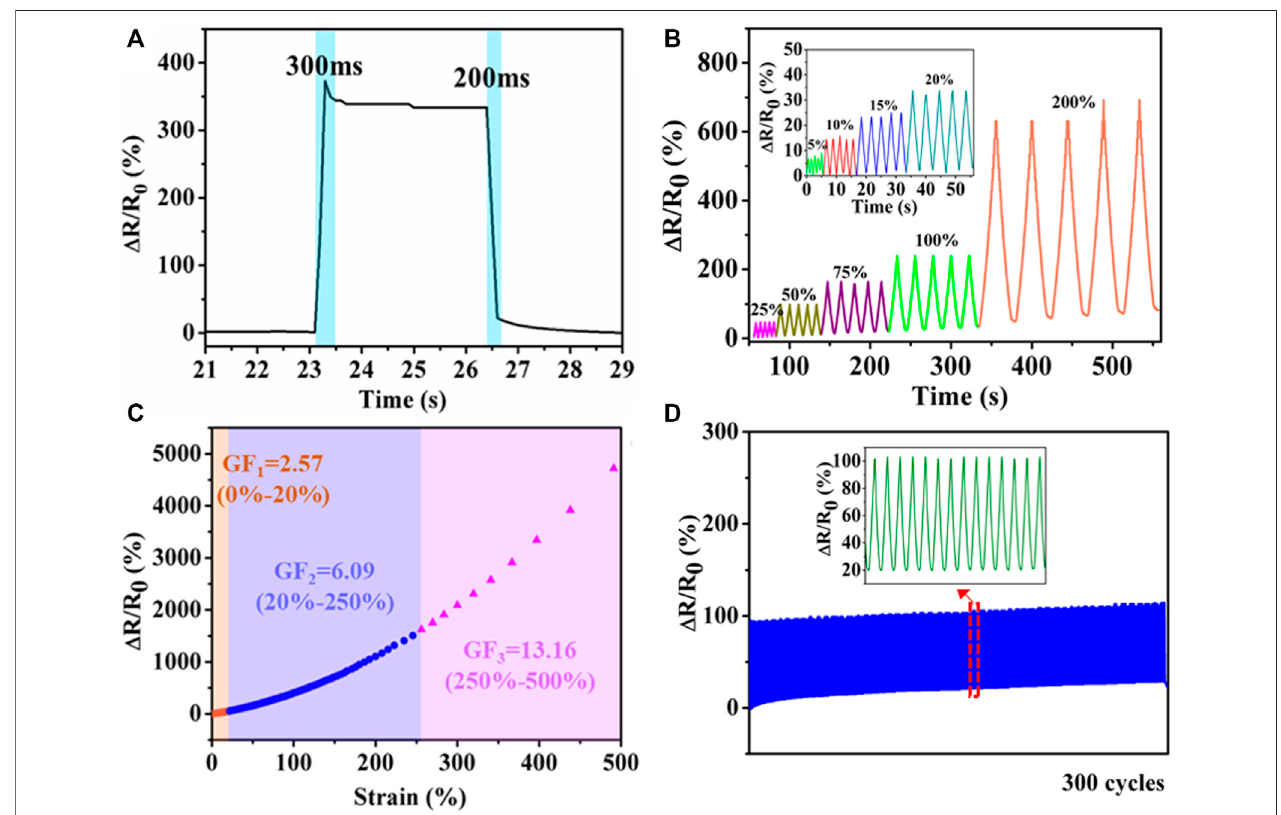
FIGURE6| StrainsensingbehaviorofPHEAA-GE-Gl-LiClorganohydrogel. (A) Responsetime, (B) therelativeresistanceunderdifferentsmallreciprocatingstrains (5, 10, 15, and 20%) and large reciprocating strains (25, 50, 75, 100, and 200%), (C) relative resistance changes and corresponding gauge factors variation with successive tensile strain from 0 to 500%, (D) the relative resistance change under cyclic loading of 50% for 300 cycles.